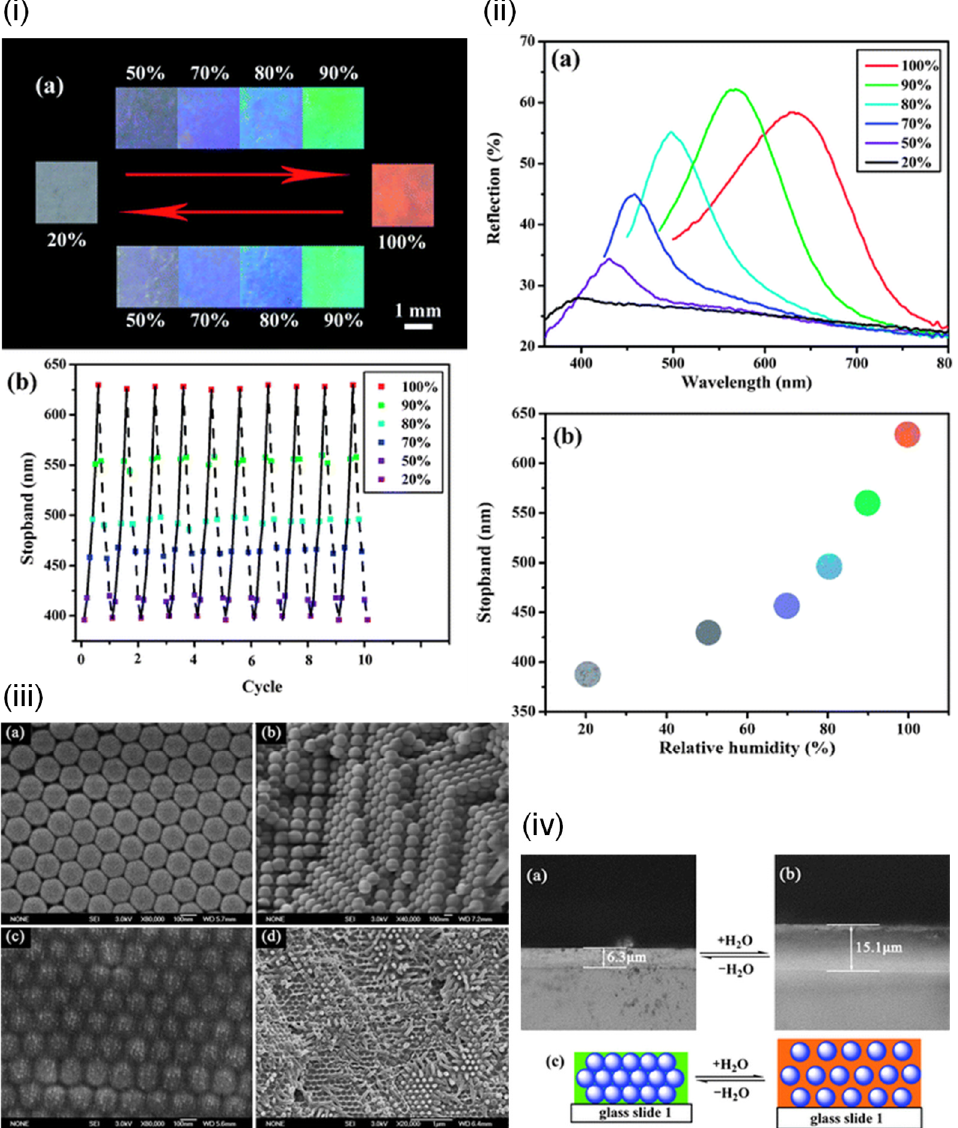
Figure 4. Colorimetric indicator. ( i ) Reversible changes of ( a ) color and ( b ) stopband with changing RH. ( ii ) ( a ) UV-vis spectra of the films under different RH. ( b ) Relationship between the stopband and RH. ( iii ) Scanning electron microscope (SEM) images of the fabricated hydrogel. P(St–MMA–AA) PC seen from the ( a ) top and ( b ) cross-view. PAAm–P(St–MMA–AA) observed from the ( c ) top and ( d ) cross-view. ( iv ) Microscope images of the hydrogel in its ( a ) dry state and ( b ) wet state. ( c ) Illustration of the structure change of hydrogel before and after fully wetted in water. Adapted with permission from ref. [11]. Copyright 2008 Royal Society of Chemistry.